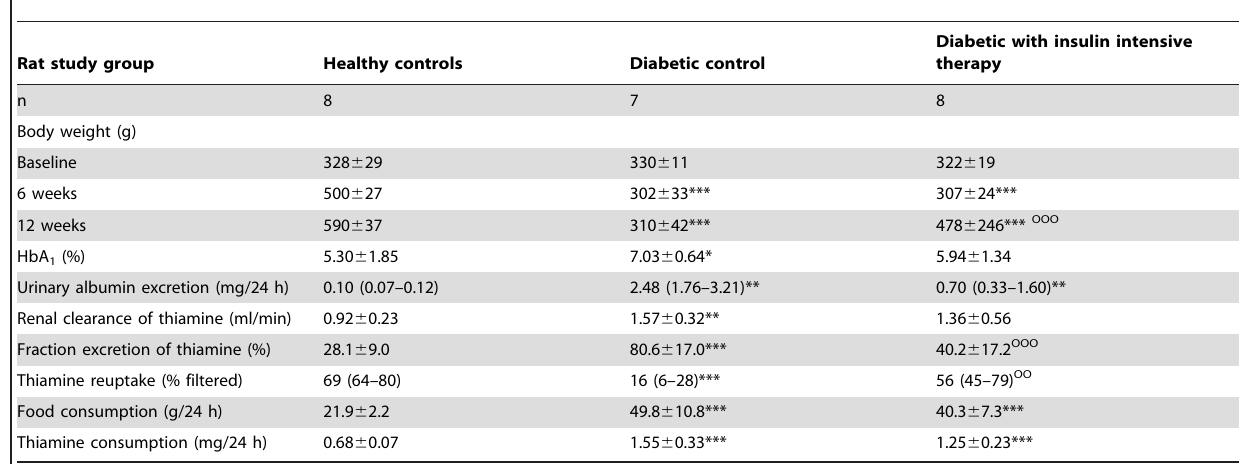
Table 1. Physiological and biochemical characteristics of streptozotocin-induced diabetic rats and healthy controls.